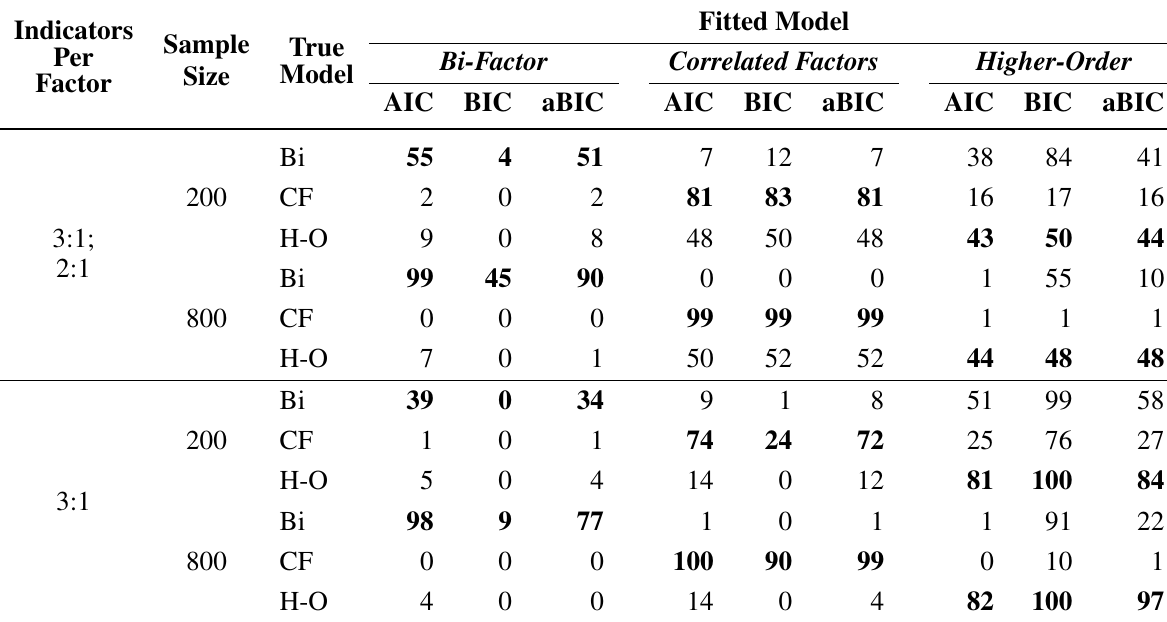
Table 4. Percentage of solutions selected by each information criterion (rounded to nearest whole